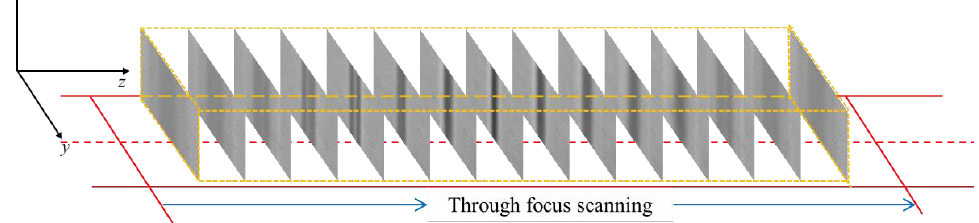
Figure 3. Model of the gold line to be measured.